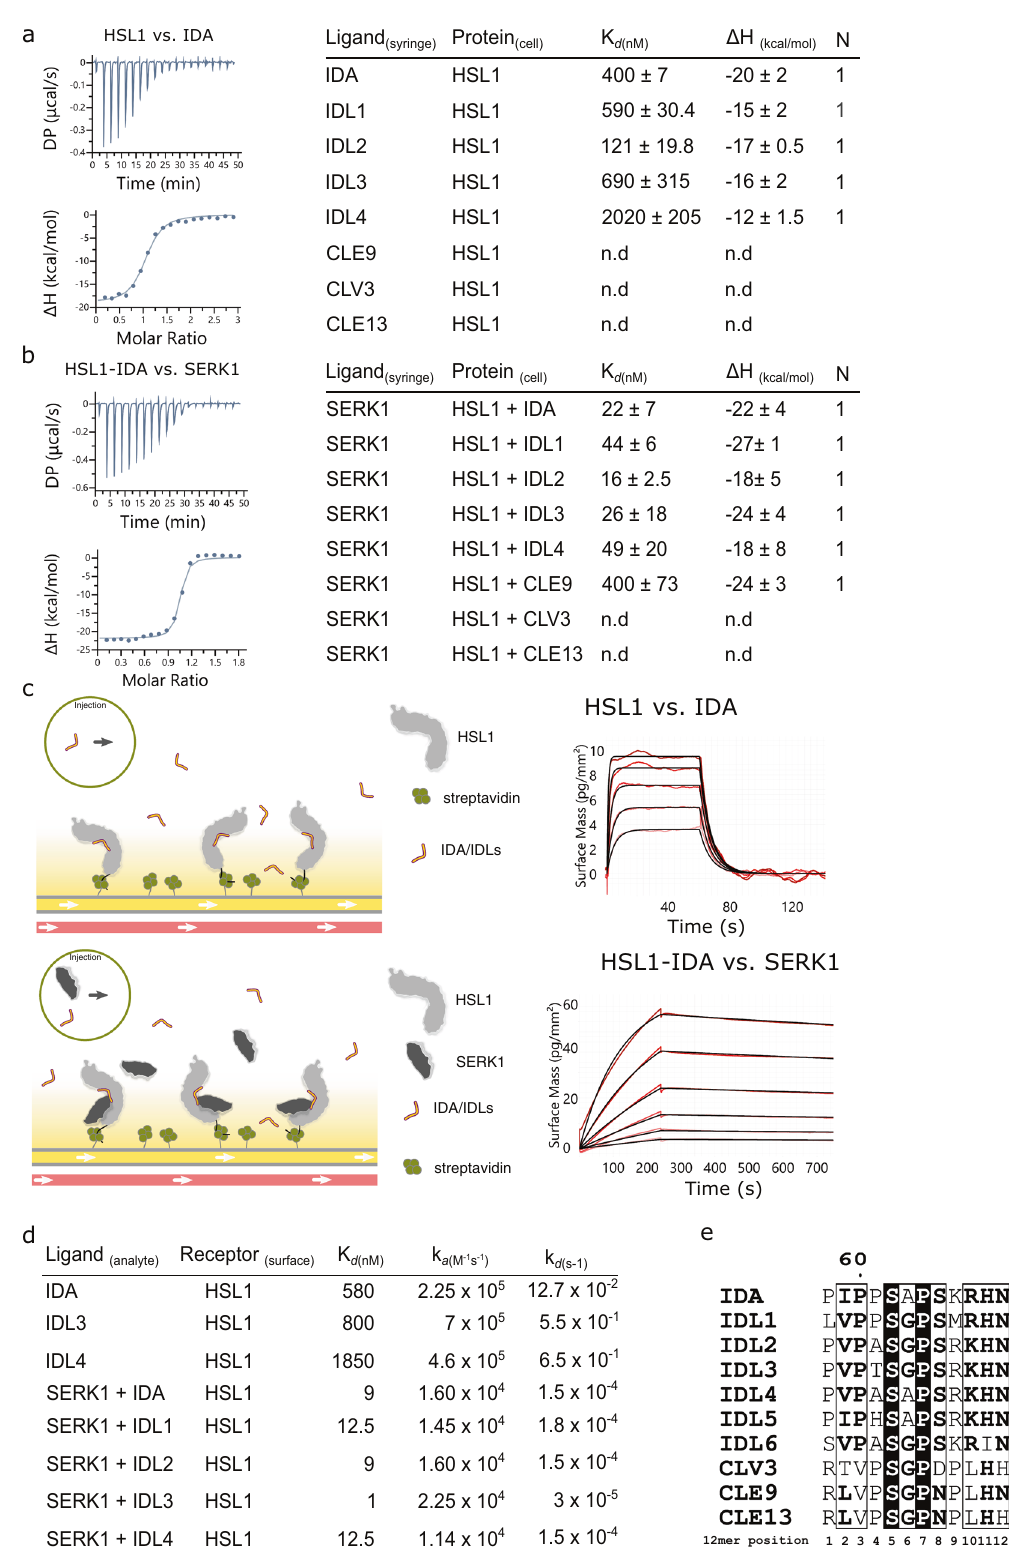
region (Supplementary Fig. 6). Superposition of the four crystal structures yielded an R.M.S.D of ~0.6 Å comparing 590 C α atom pairs, with IDL peptides perfectly aligning to each other (Fig. 2a).